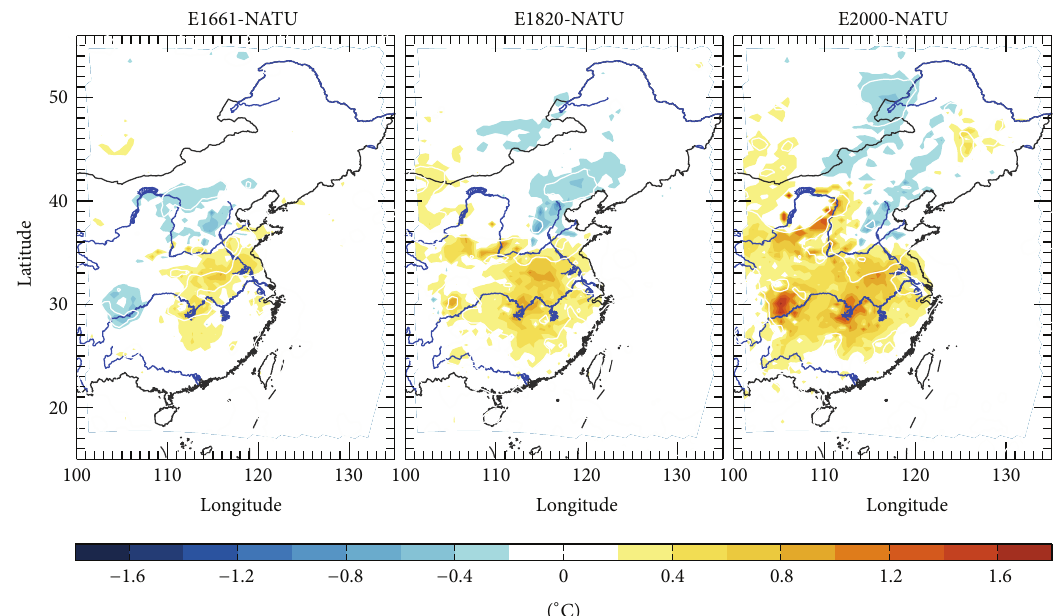
Figure 3: Changes in surface air temperature induced by land cover conversions from natural vegetation to cropland in 1661, 1820, and 2000.